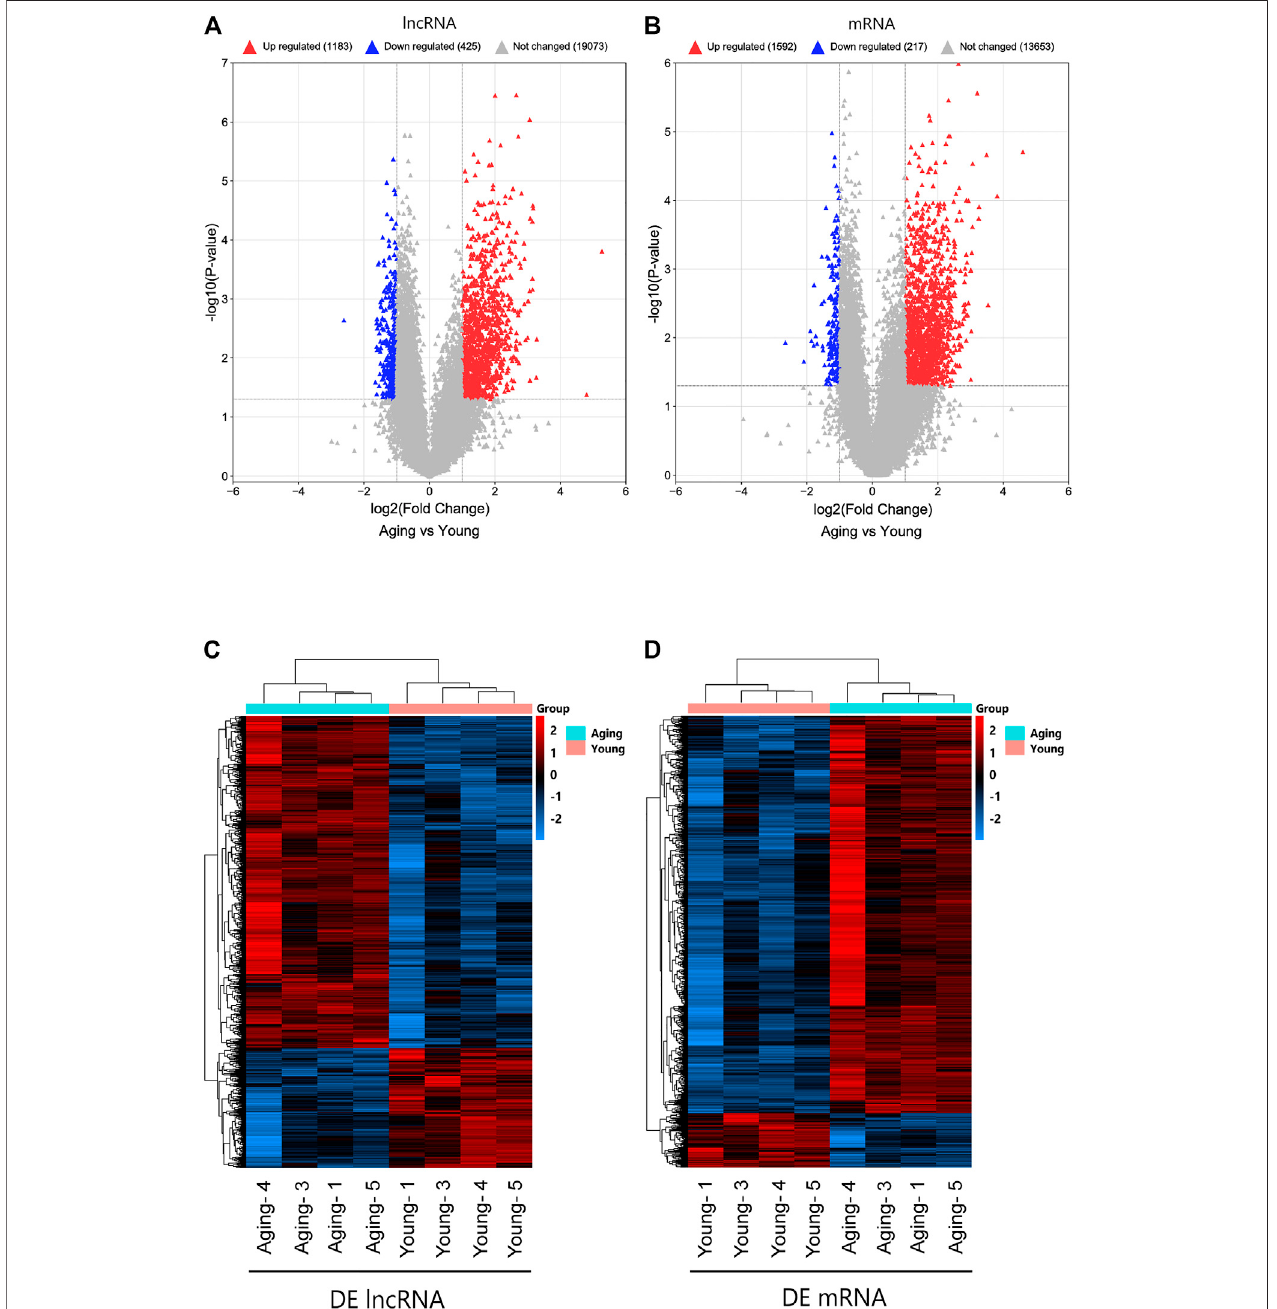
FIGURE 2 | Identi fifi cation of DE lncRNAs and mRNAs. Volcano plot of DE lncRNAs (A) and DE mRNAs (B) . Heatmap of DE lncRNAs (C) and DE mRNAs (D) . DE, differentially expressed.